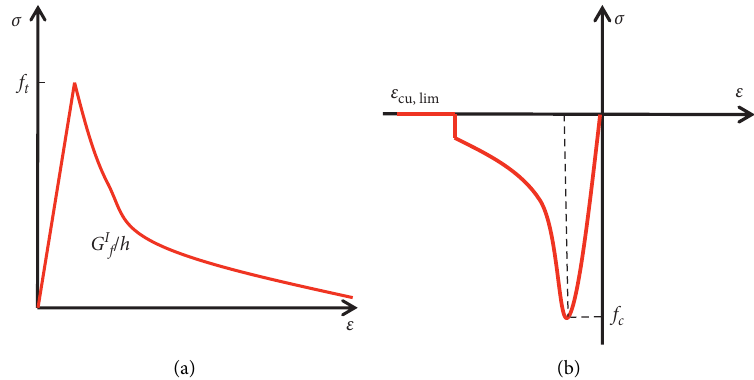
Figure 15: Constitutive models for tensile and compressive behavior in DIANA [24]: (a) tension softening model; (b) fib 2010 compressive model.